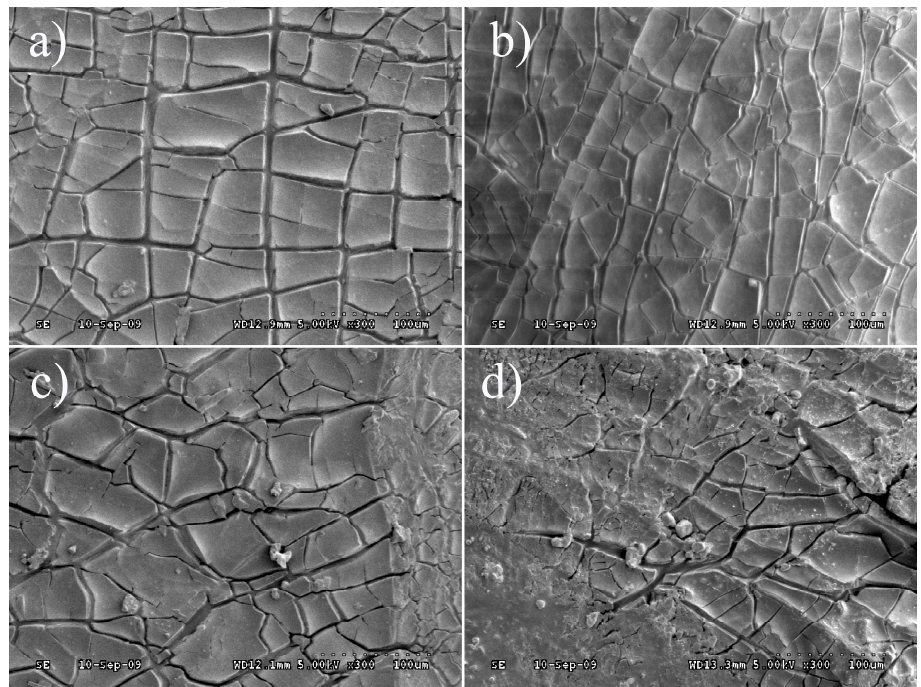
Figure 8. Apparent morphology of virgin bitumen after UV aging in different environments: ( a ) UV; ( b ) UV + Water; ( c ) UV + Acid; and, ( d ) UV + Salt.